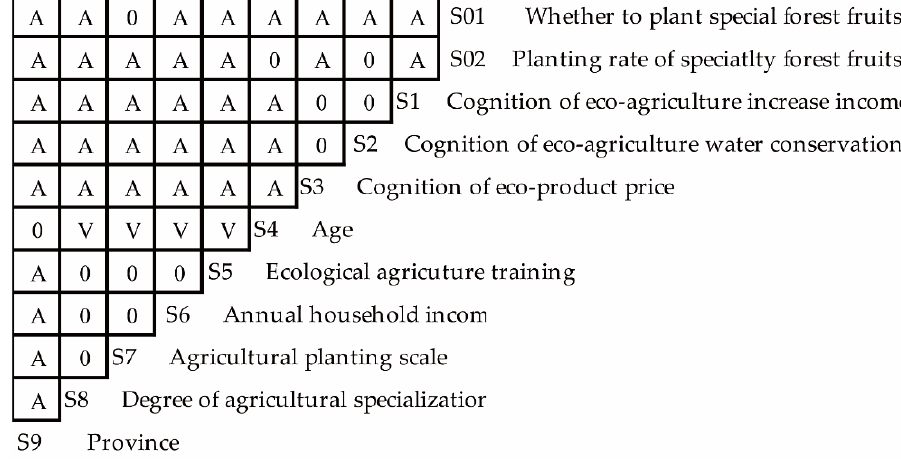
Figure 4. Relationship between factors affecting response to the planting of specialty orchard fruits.